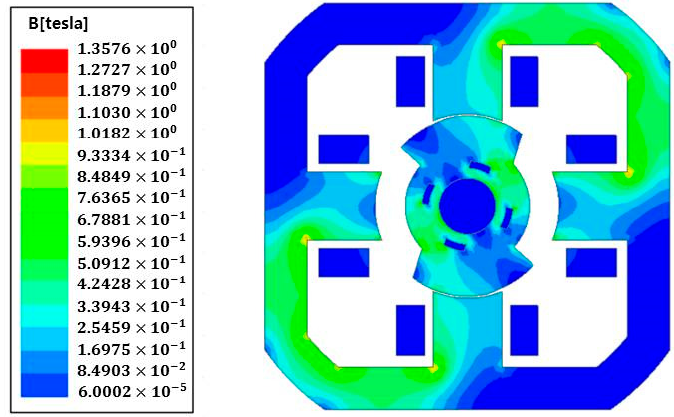
Figure 14. Aligned position flux density of the designed SRM.